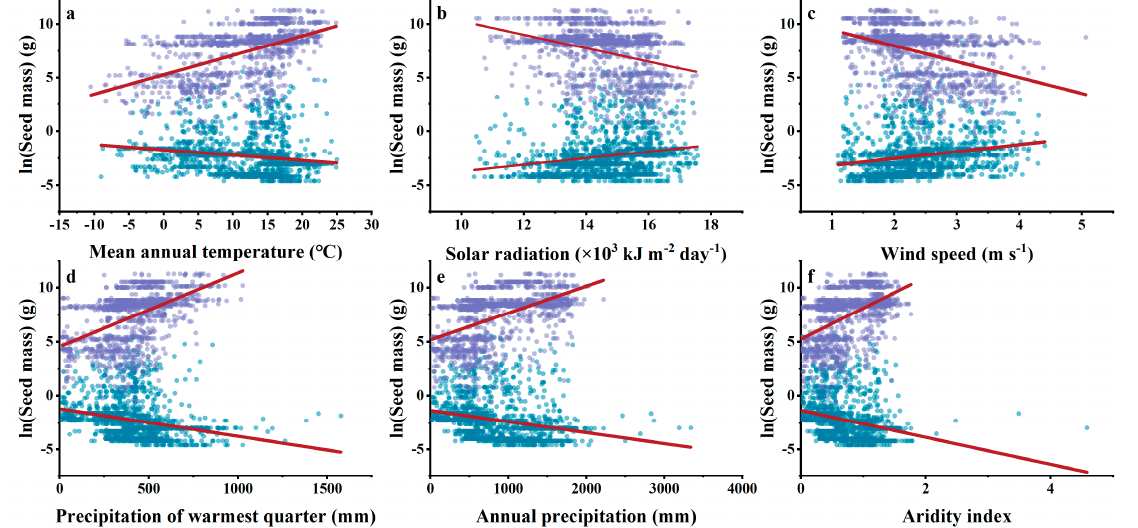
Figure 6. Relationships between the minimum and maximum seed masses of angiosperms and ( a ) Mean annual temperature; ( b ) Solar radiation; ( c ) Wind speed; ( d ) Precipitation of the warmest quarter; ( e ) Annual precipitation and ( f ) Aridity index. The purple dots indicate the maximum value of the angiosperm seed mass and the blue dots indicate the minimum value of the angiosperm seed mass. The solid line indicates a significant linear regression ( p < 0.05).